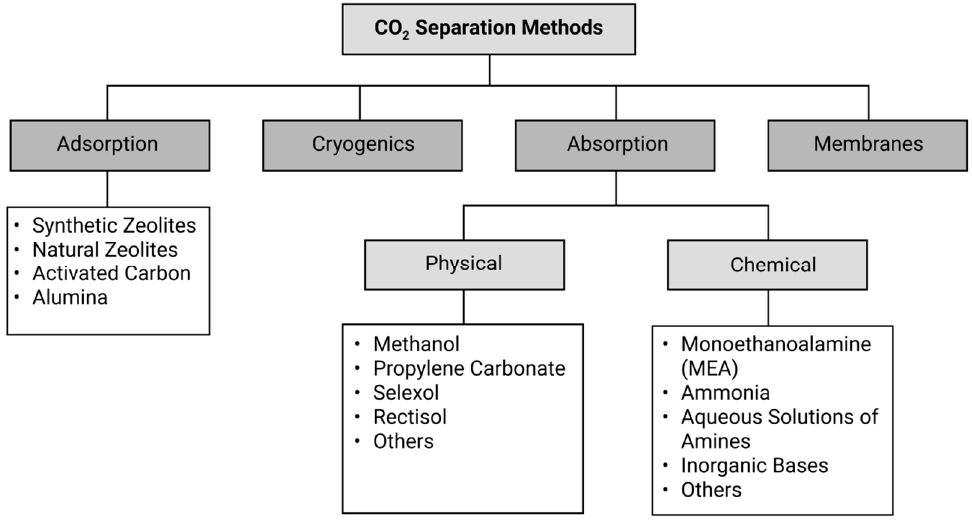
Figure 2. Carbon dioxide separation methods.